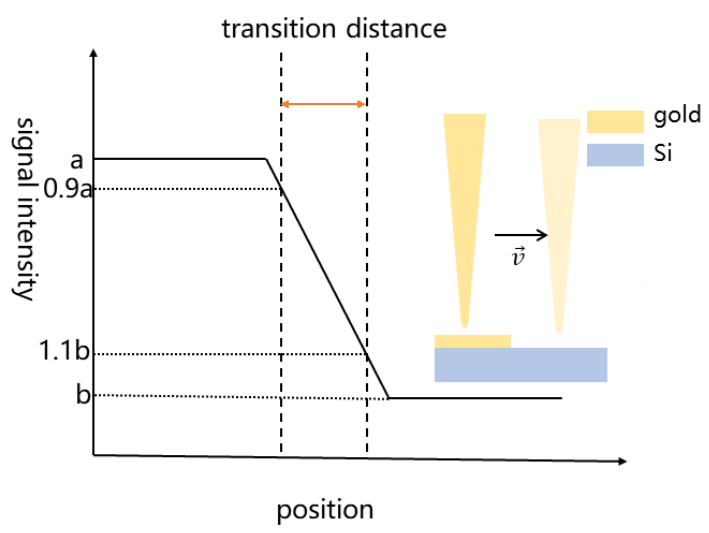
Figure 6. Schematic diagram of scattering signal in the scanning process of metal strips on silicon substrate.